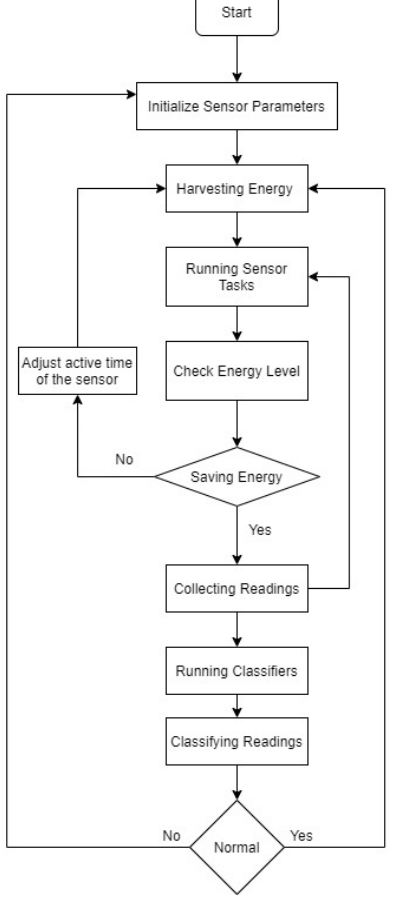
Figure 5. Flowchart of the main managed operations in SpWBAN.